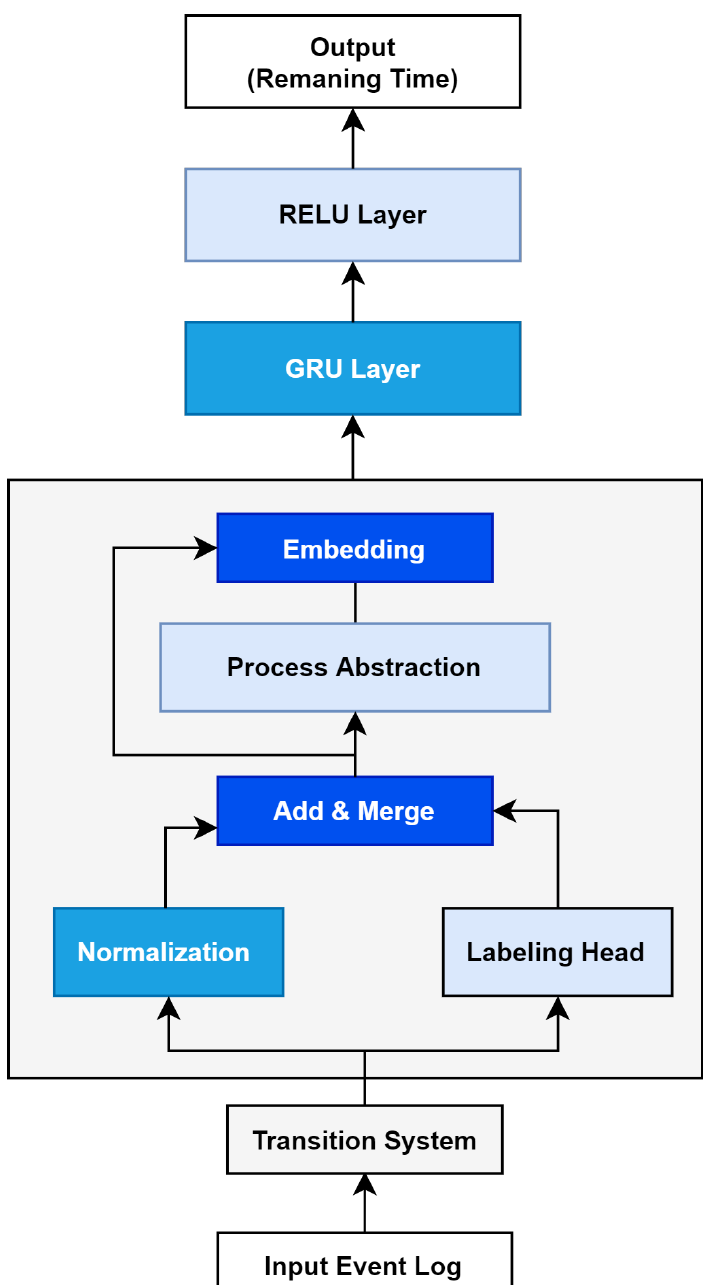
Figure 3. Transition system based embedding for digital twin